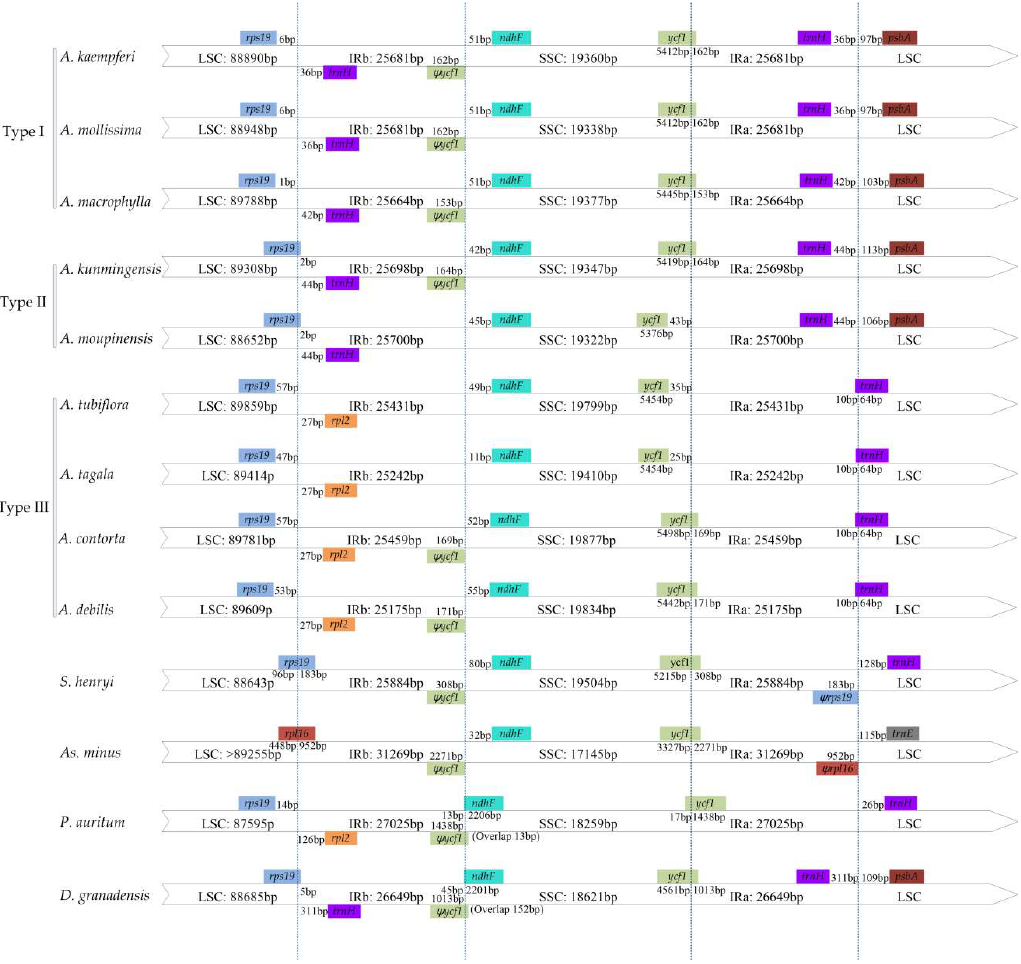
Figure 3. Comparison of the borders of large single copy (LSC), small single copy (SSC) and inverted repeat (IR) regions among 13 cp genomes. Number above the gene features means the distance between the ends of genes and the borders sites. These features are not to scale.